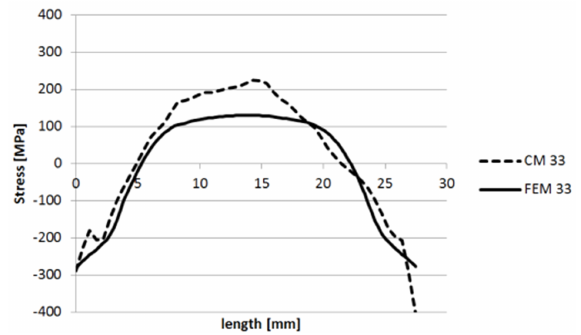
Figure 30. Stress levels in 33 direction along the CD line segment.